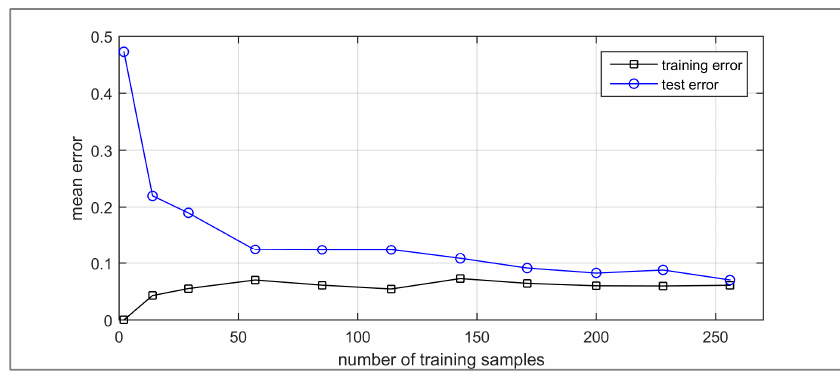
Figure 9. Learning curves for the SVM classifier showing the classifier is sufficiently trained with approximately 50 training images. approximately 50 training